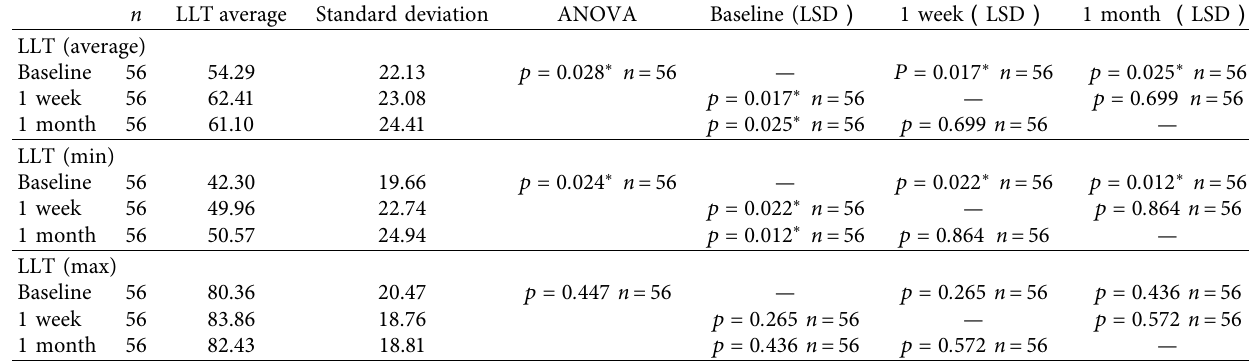
Table 5: Short-term change of LLT (average, minimum, and max) after